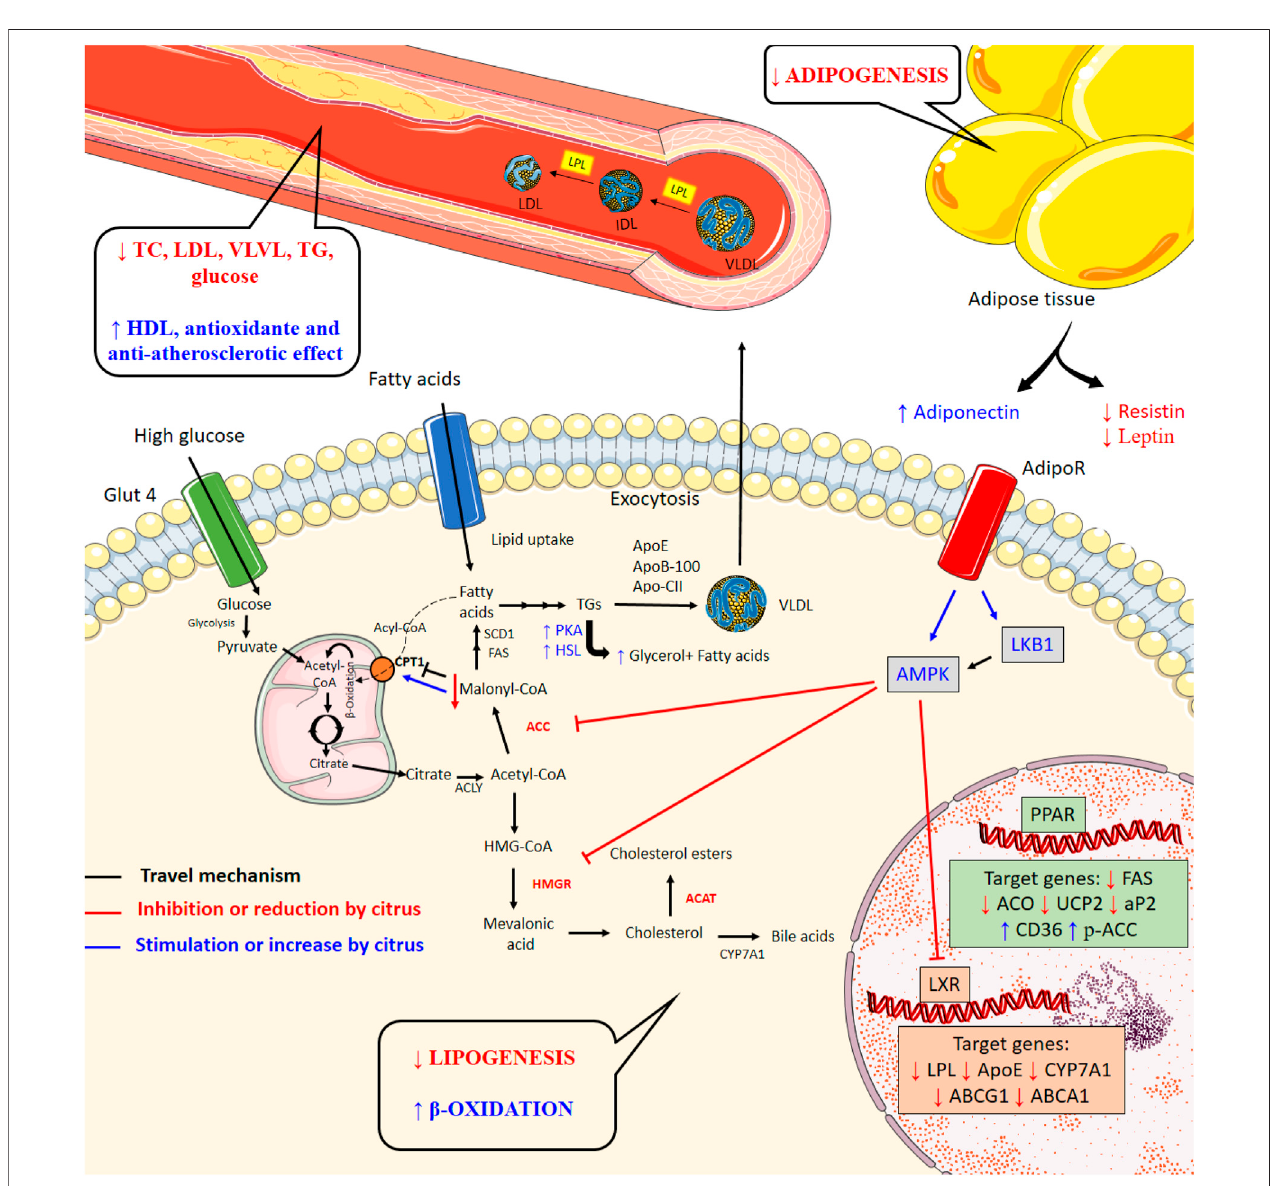
FIGURE 6 | Biochemical and tissue changes caused by diets high in fat and calories (black lines) and mechanisms of action of Citrus products upon metabolic disorders associated with hyperlipidemia (blue lines indicate activation and red lines indicate inhibition).